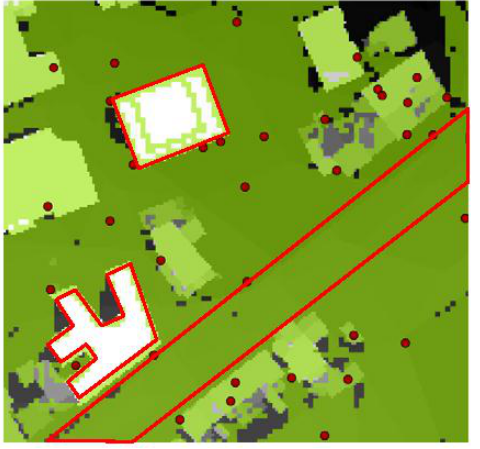
Figure 19. Coverage map of deploying 35 sensors using the context-aware method, considering the street (Zone 1), and buildings (Zone 2) as the restricted area (the red border